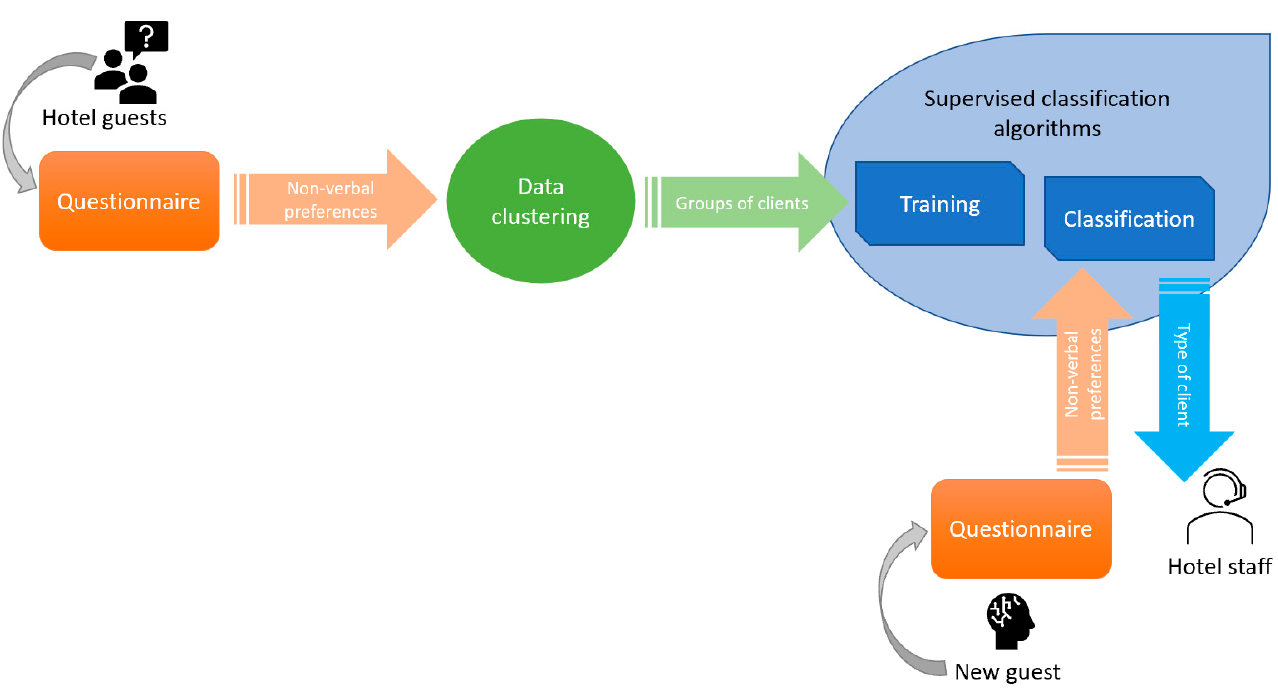
Figure 1. Schematic diagram of the research methodology.